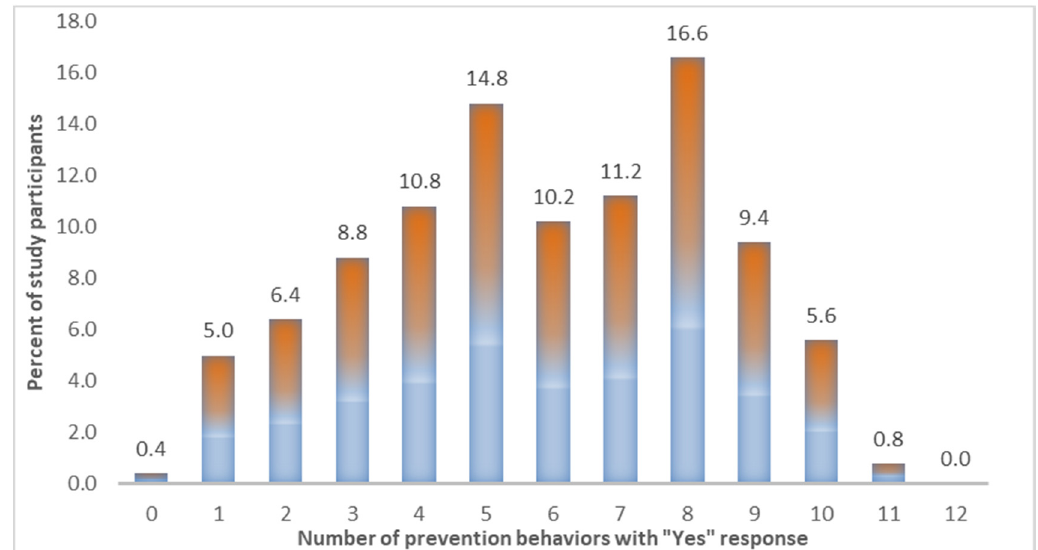
Figure 1. Percent of Study Participants by Number of Prevention Behaviors Concerning COVID-19 (with potential range from 0 to 12).